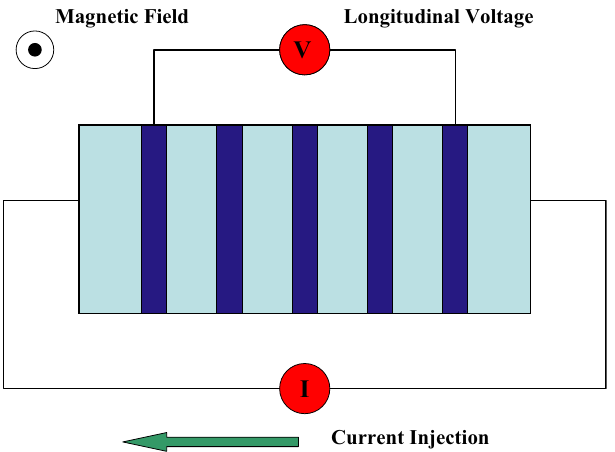
Figure 1. Schematic experimental setup to detect the expected longitudinal magnetoresistance in a 2D quantum Hall sample. The applied magnetic field is perpendicular to the 2D plane of motion of the electron (depicted as stripes) and is directed out of the page (solid dot).